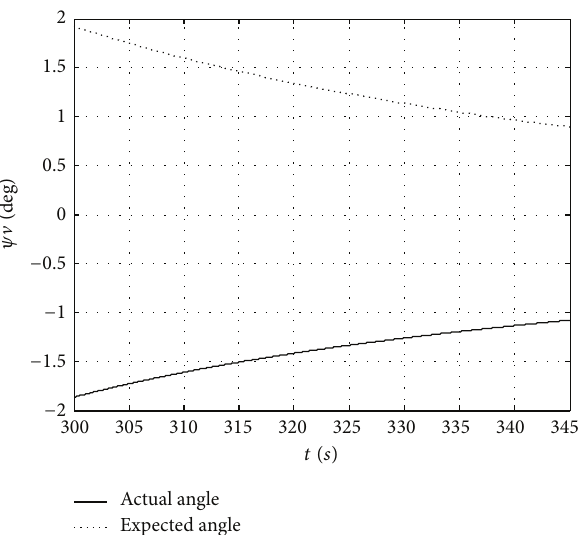
Figure 16: Simulation result of slide angle.